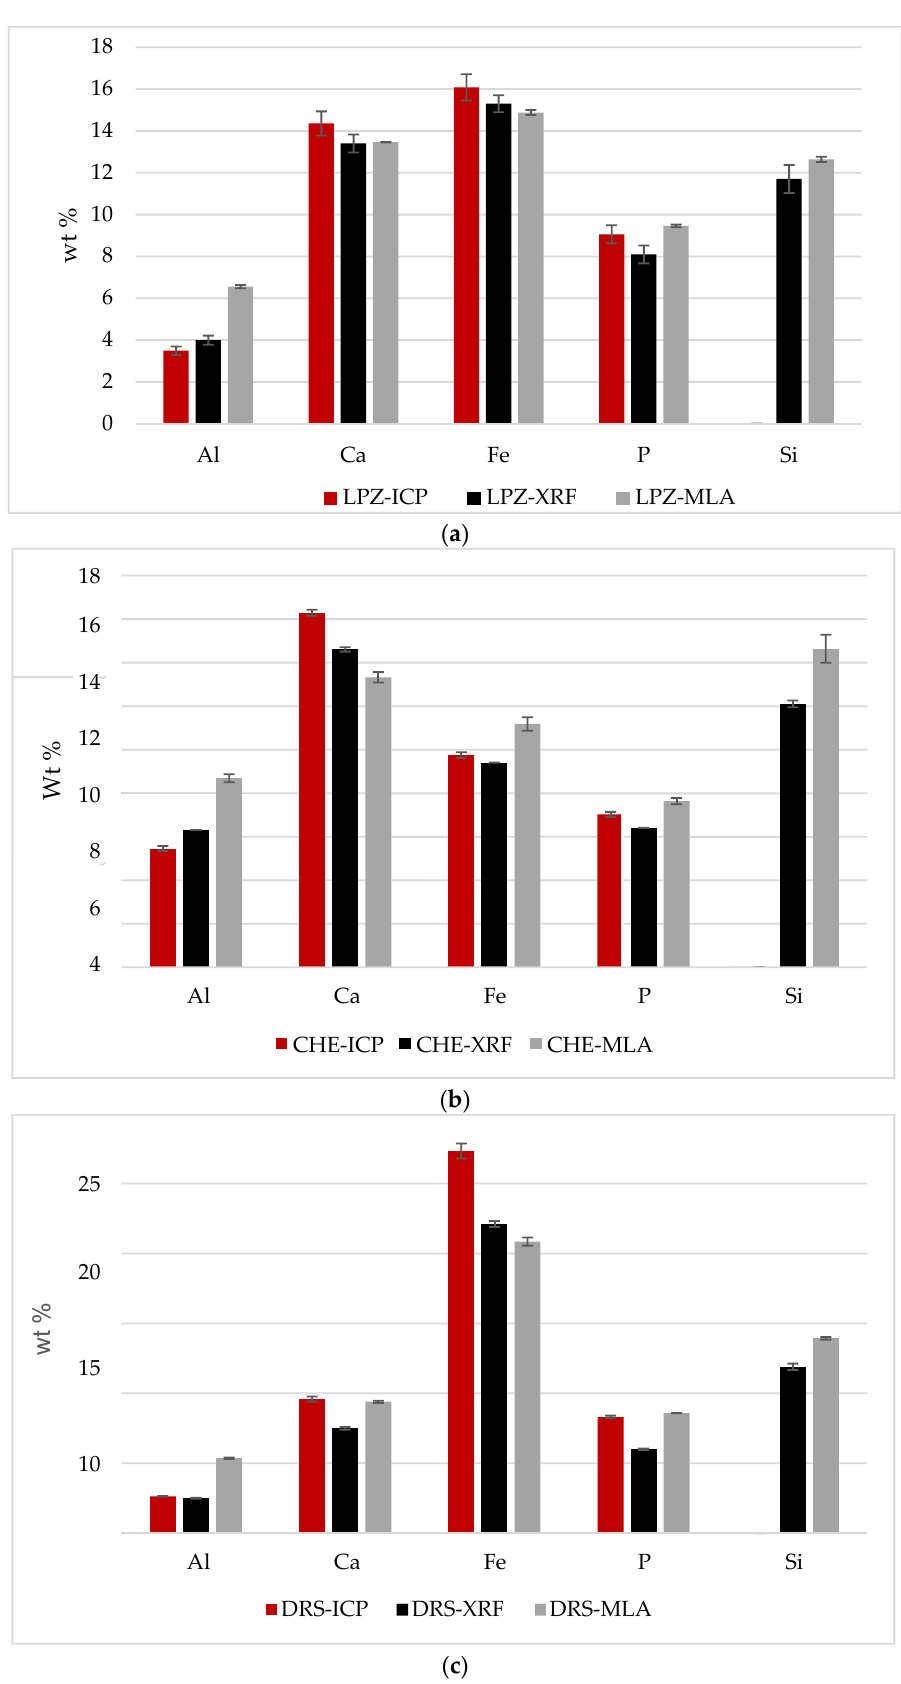
Figure 3. Compositional distributions of main elements. Error bars are based on standard